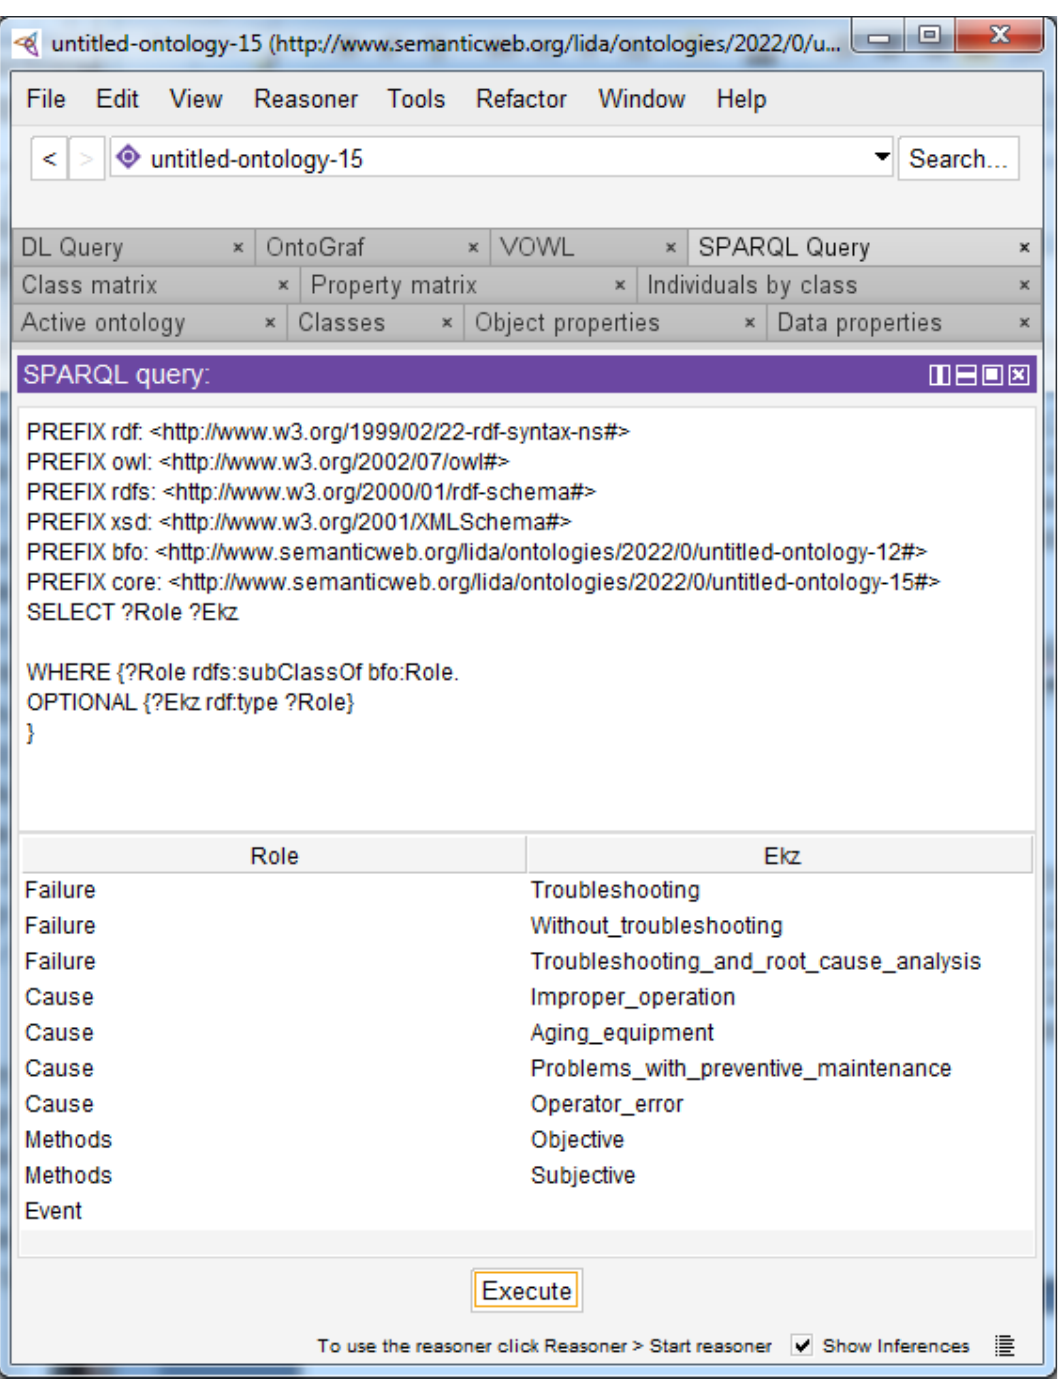
Figure 6. Query 2.